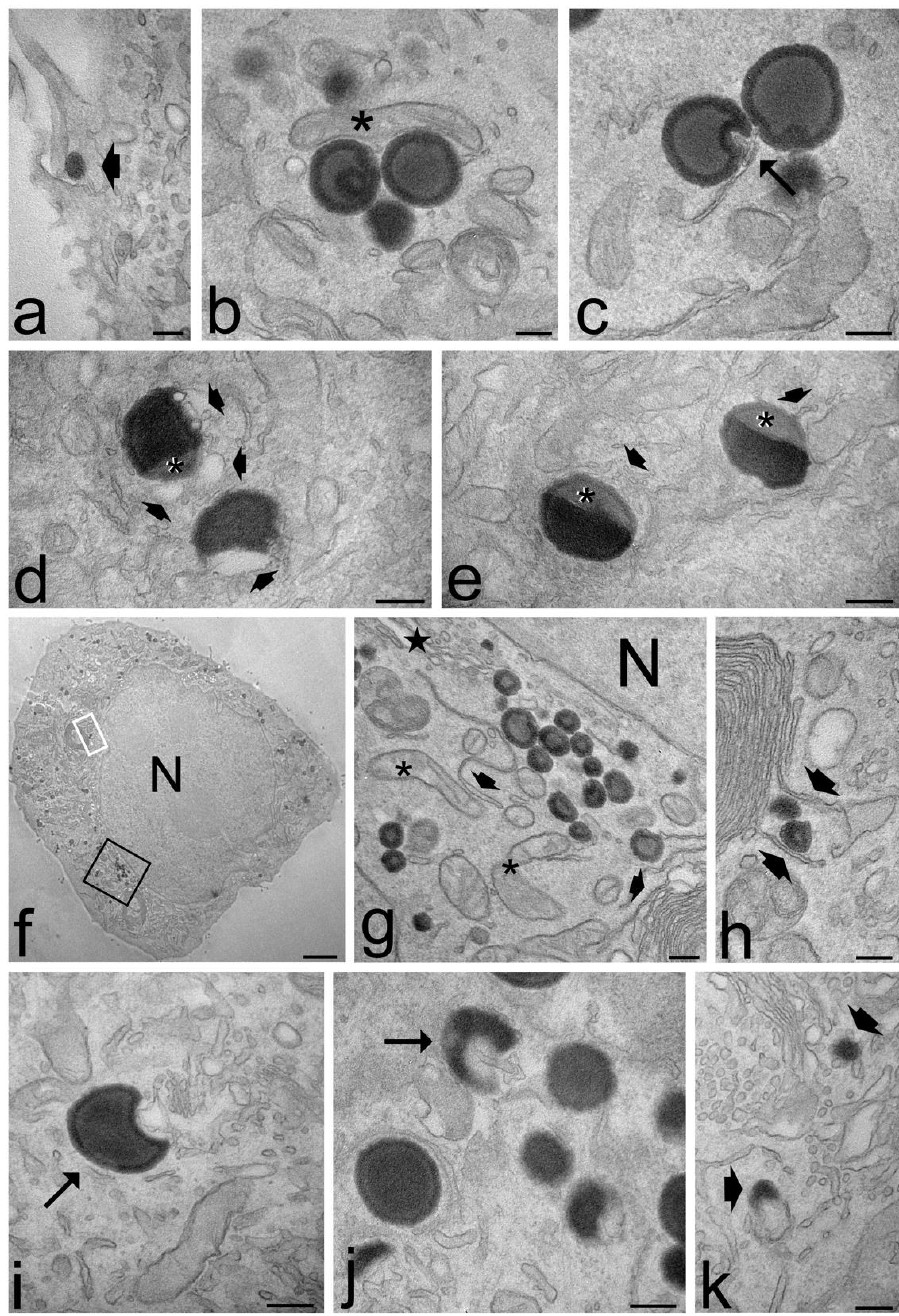
Figure 7. Transmission electron micrographs of keratinocytes ( a , d , j , k ), myoblasts ( b , f , g , h ) and fibroblasts ( c , e , i ) after 2 h ( a – e ) and 24 h incubation ( f – k ) with ET. ( a ) An ET (arrowhead) is entering the cell. ( b ) A mitochondrion (asterisk) occurs very close to ET distributed in the cytosol. ( c ) Smooth endoplasmic reticulum into an ET indentation (arrow). ( d , e ) ET at various degree of degradation: note the smooth vesicles at their periphery (thin arrows) and the decreased electron density (asterisks). ( f , g ) After 24 h incubation, many ET are distributed in the cytoplasm, sometimes very close to the nucleus (N); note the well-preserved morphology of mitochondria (asterisks), endoplasmic reticulum (arrowheads) and Golgi apparatus (star). ( h ) Smooth endoplasmic reticulum cisternae surround two ET (arrowheads). ( g , h ) High magnification details corresponding to the black and white framed areas in ( f ), respectively. ( i , j ) Crescent-like ET with smooth endoplasmic reticulum inside their concavity. ( k ) ET remnants (arrows) surrounded by many smooth vesicles and tubules. Bars 200 nm ( a – e , g – k ), 2 μm ( f ).